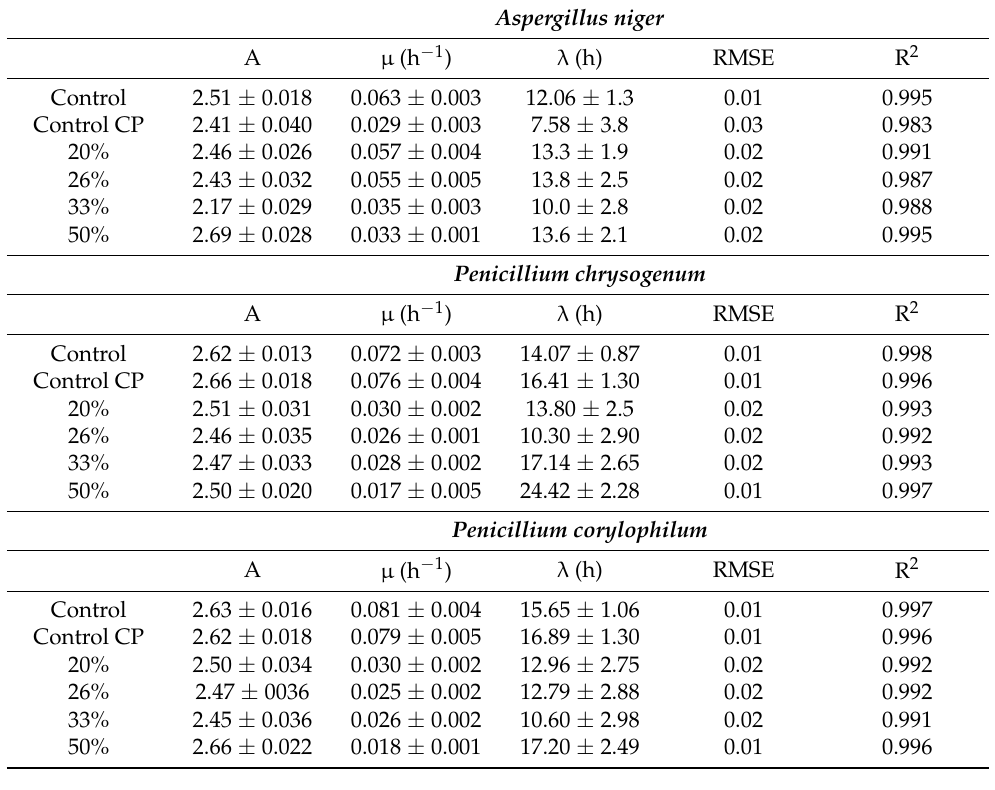
Table 2. Parameters ( µ maximum growth rate; λ lag phase) of the modified Gompertz equation describing the growth of the molds treated at different concentrations of the pasteurized aqueous extracts from poolish-type sourdough fermented with Lactiplantibacillus plantarum NRRL B-4496 for 48